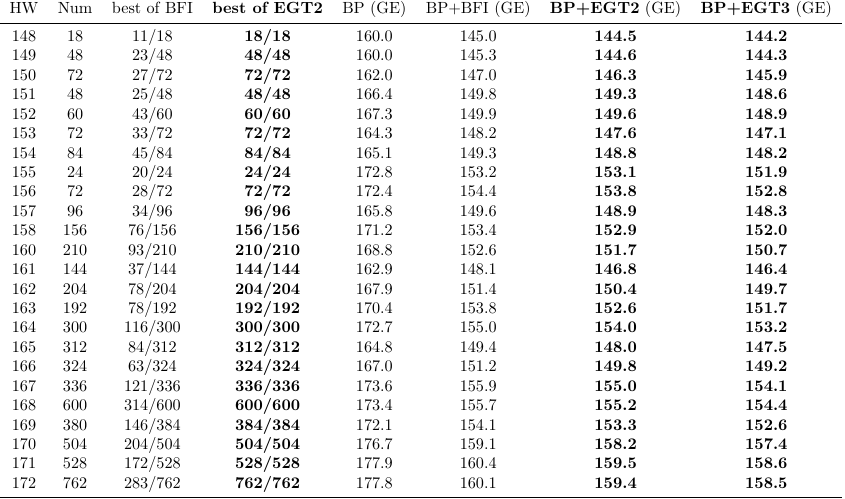
Table 9: The results of implementation cost of matrices from [LSL + 19] for STM 90 nm